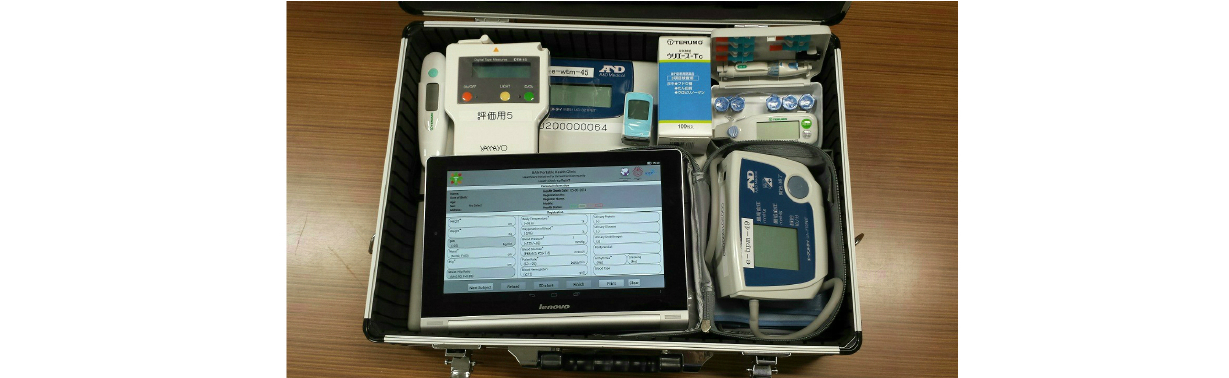
Figure 1. The Portable Health Clinic System package.